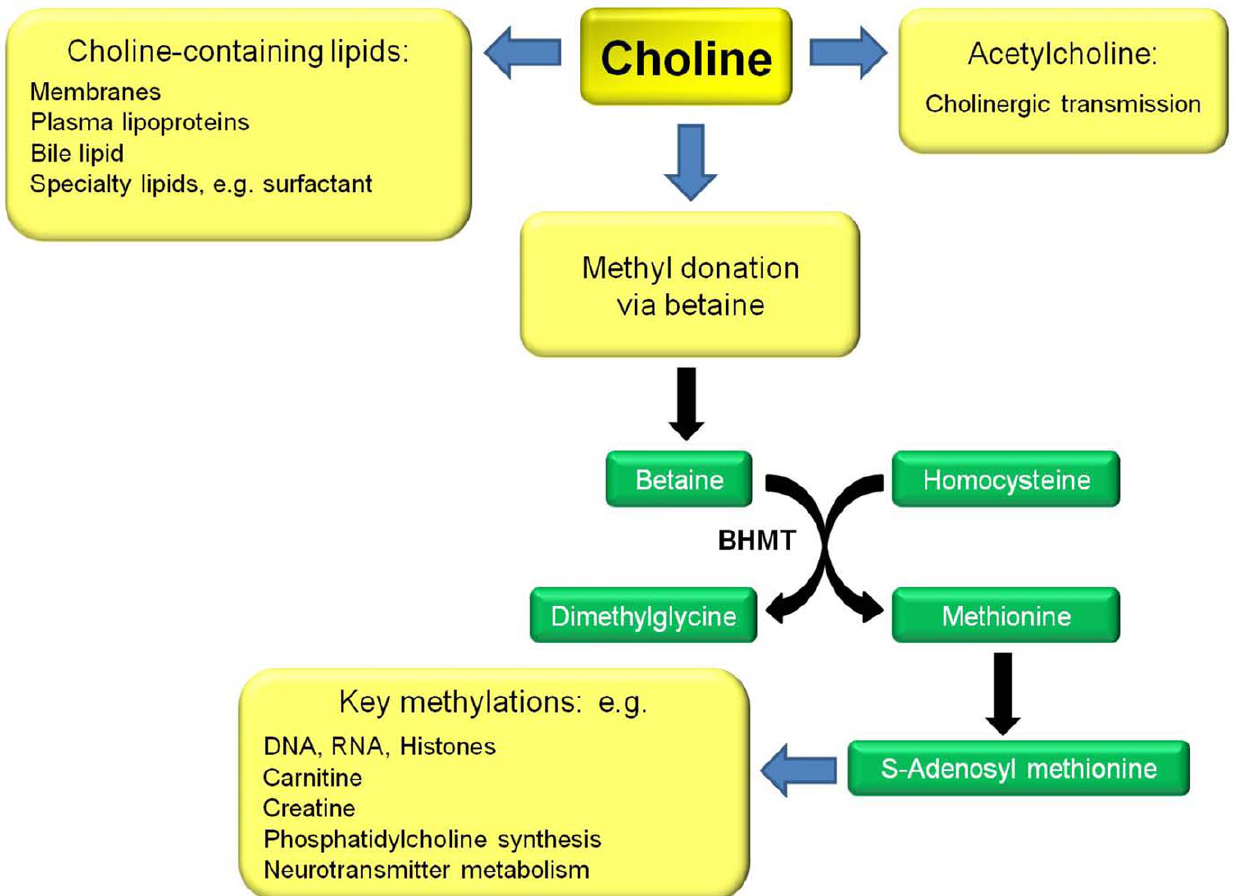
Figure 1. Simplified scheme to show the roles of choline and its metabolites. BHMT: betaine-homocysteine S -methyltransferase.